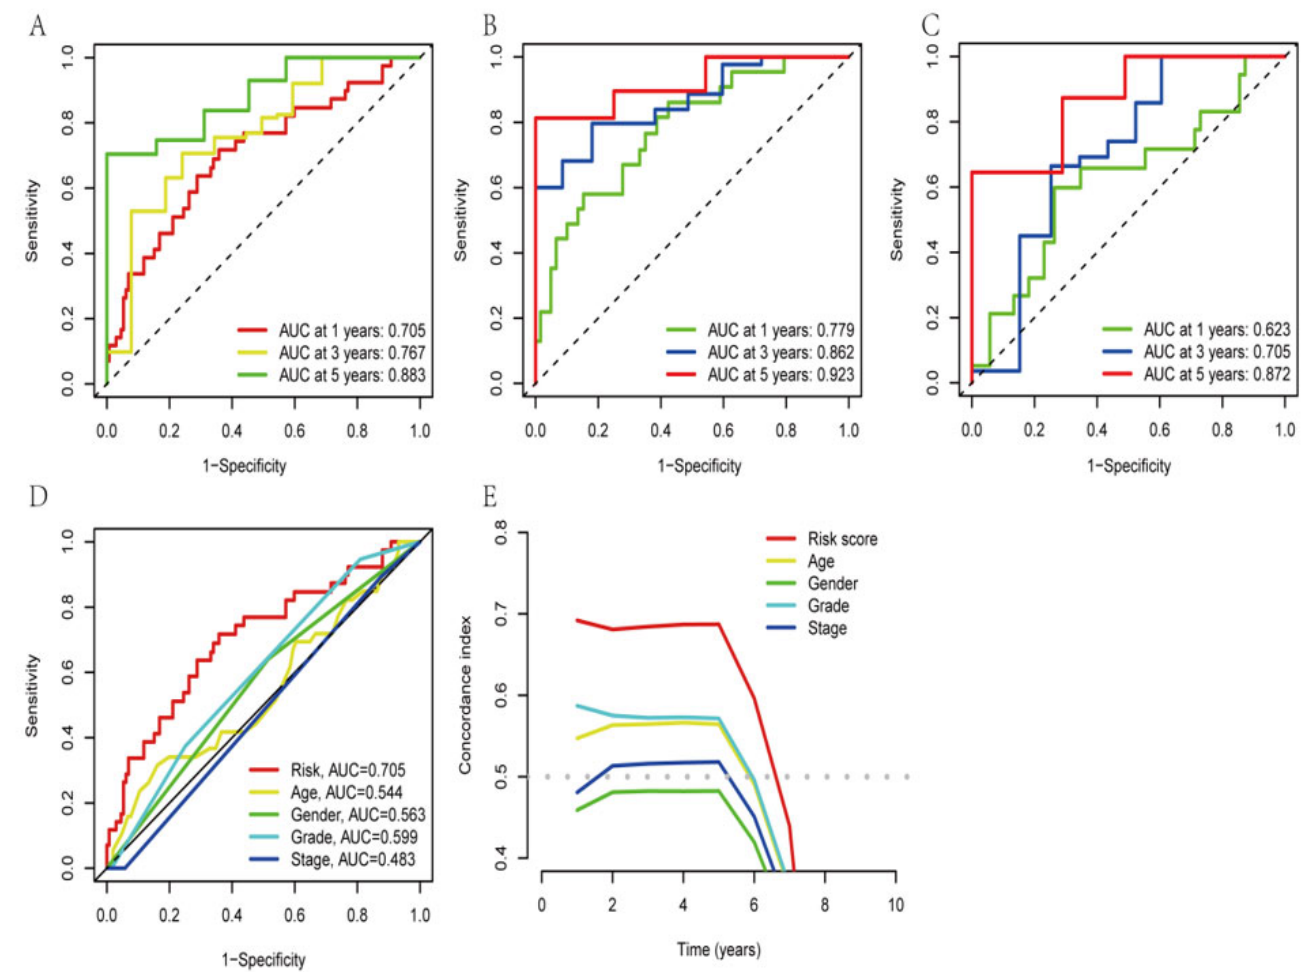
Figure 4. Confirming the signature of the AGGLncRNAs. ( A – C ) Time-dependent ROC analysis for one year, three years, and five years, for evaluating the sensitivity and specificity of this prognostic model. A: all, B: train, C: test. ( D ) The ROC curve for the various characteristics. ( E ) The C-index curves of different features.